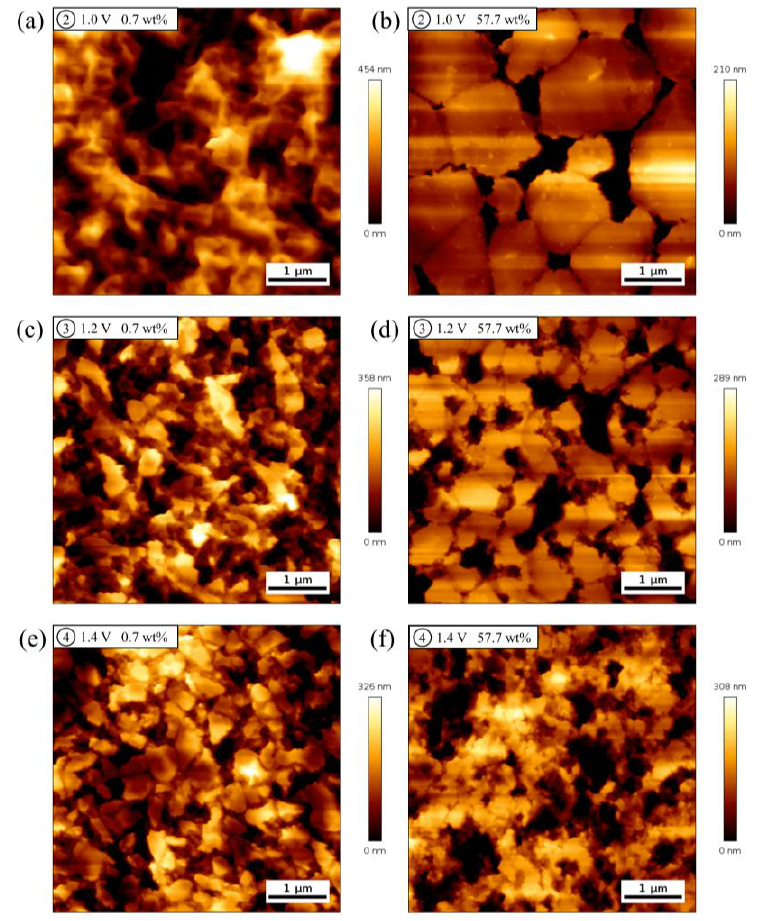
Figure 6. ( a − f ) AFM images of Au(111) electrode surface after holding at different potentials for 3 min in ethaline with water contents 0.7 wt% ( a , c , e ) and 57.7 wt% ( b , d , f ). ( a , b ) 1 V; ( c , d ) 1.2 V; ( e , f ) 1.4 V.